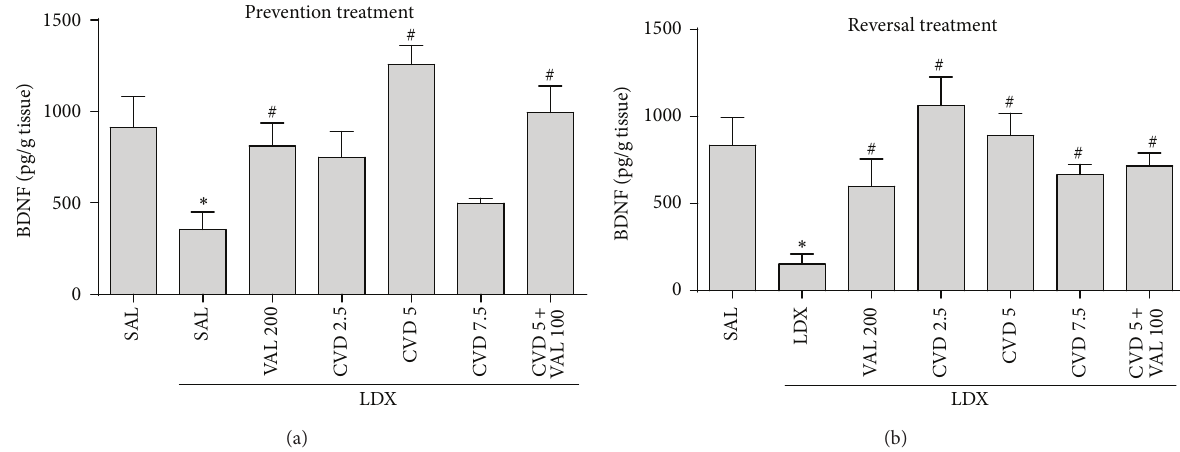
Figure 6: Levels of brain derived neurotrophic factor (BDNF) in the hippocampus of rats submitted to the prevention (a) and reversal (b) treatments. Data were analyzed by one-way ANOVA followed by Student-Newman-Keuls post hoc test. Values are expressed as mean ± SEM (6–8 animals/group). ∗ 𝑃 < 0.05 versus Sal + Sal; # 𝑃 < 0.05 versus Sal + LDX or LDX + LDX. CVD: carvedilol; LDX: lisdexamfetamine; Sal: saline; VAL: